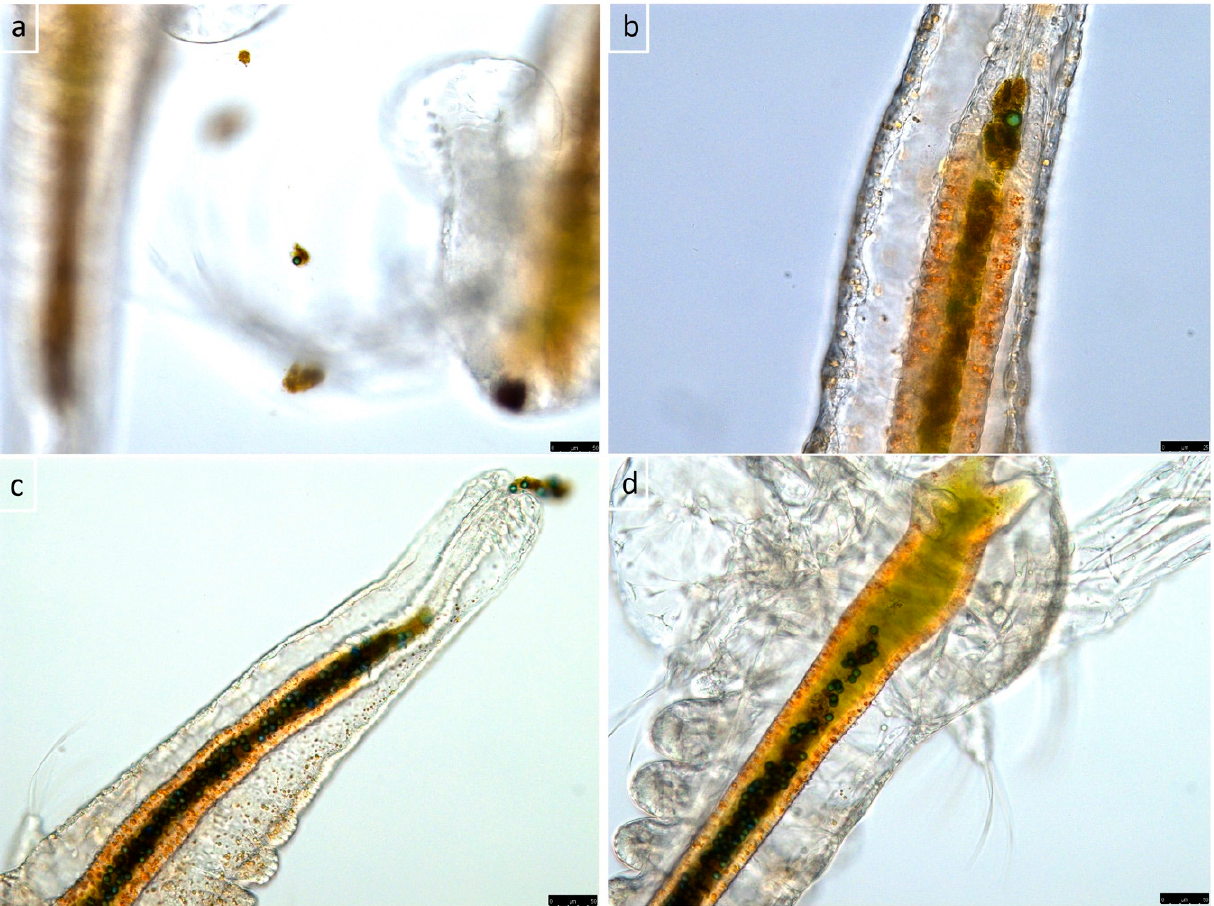
Figure 2. Ten µm of Polybead ® Blue Dyed Microspheres detected in the gut and feces of Group A specimens at T48. ( a ) Treatment A3 (10 2 MPs/mL); ( b ) treatment A4 (10 3 MPs/mL); ( c , d ) treatment A5 (10 4 MPs/mL). Scale bars: 25 µm ( a ); 50 µm ( b – d ).